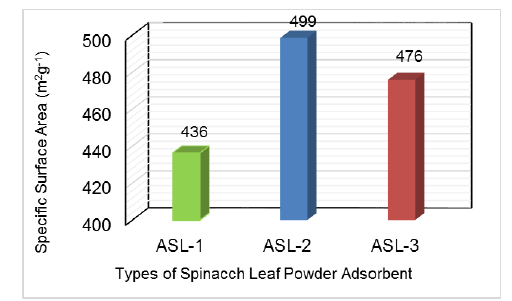
Fig. 5. Comparative study of specific surface area on different adsorbents.